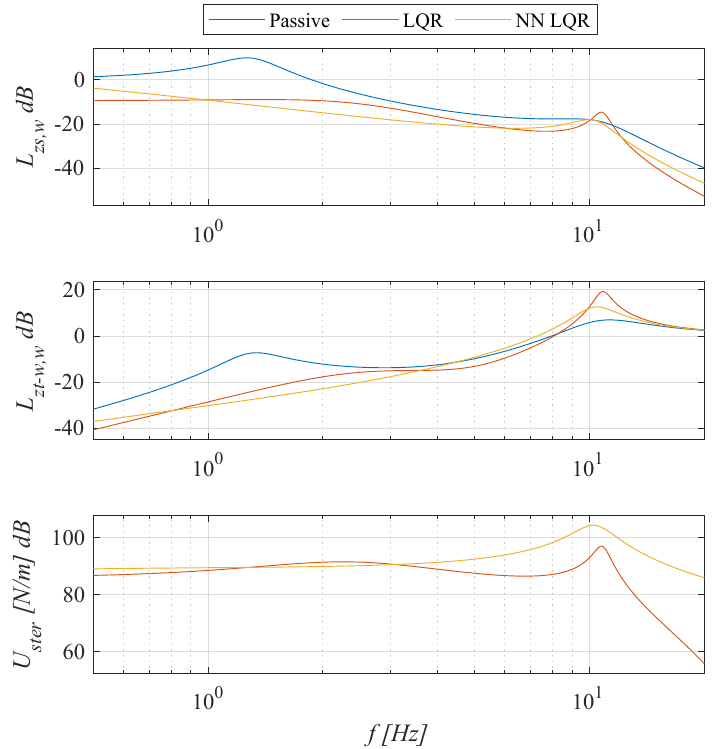
Figure 5. Comparison of the frequency characteristics of the analysed systems.